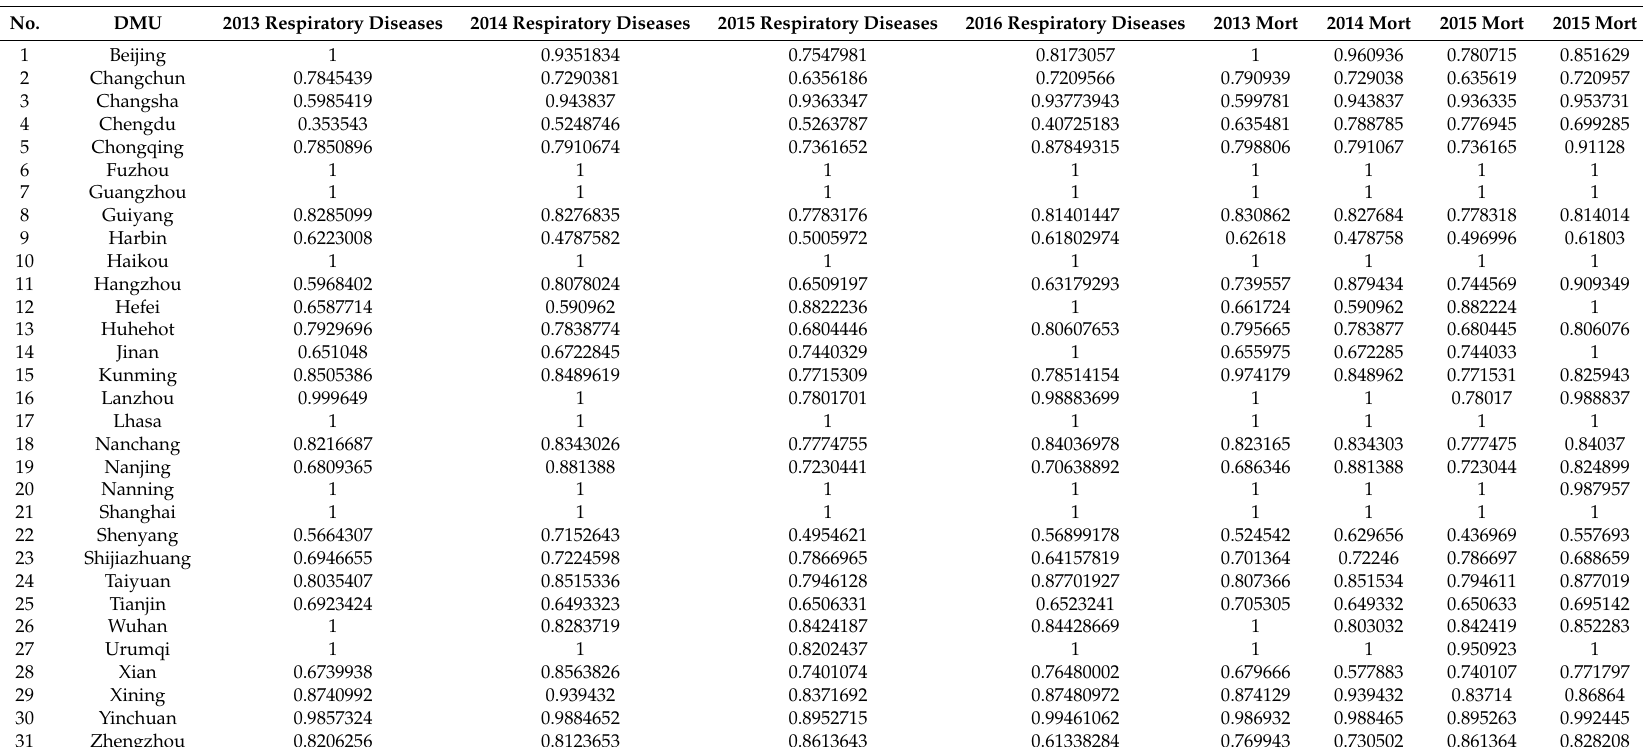
Table 6. Respiratory disease mortality efficiency